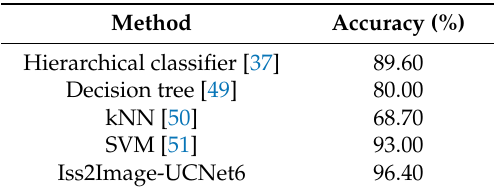
Table 7. Average accuracy comparison between Iss2Image-UCNet6 and existing methods on the DaLiAc dataset.